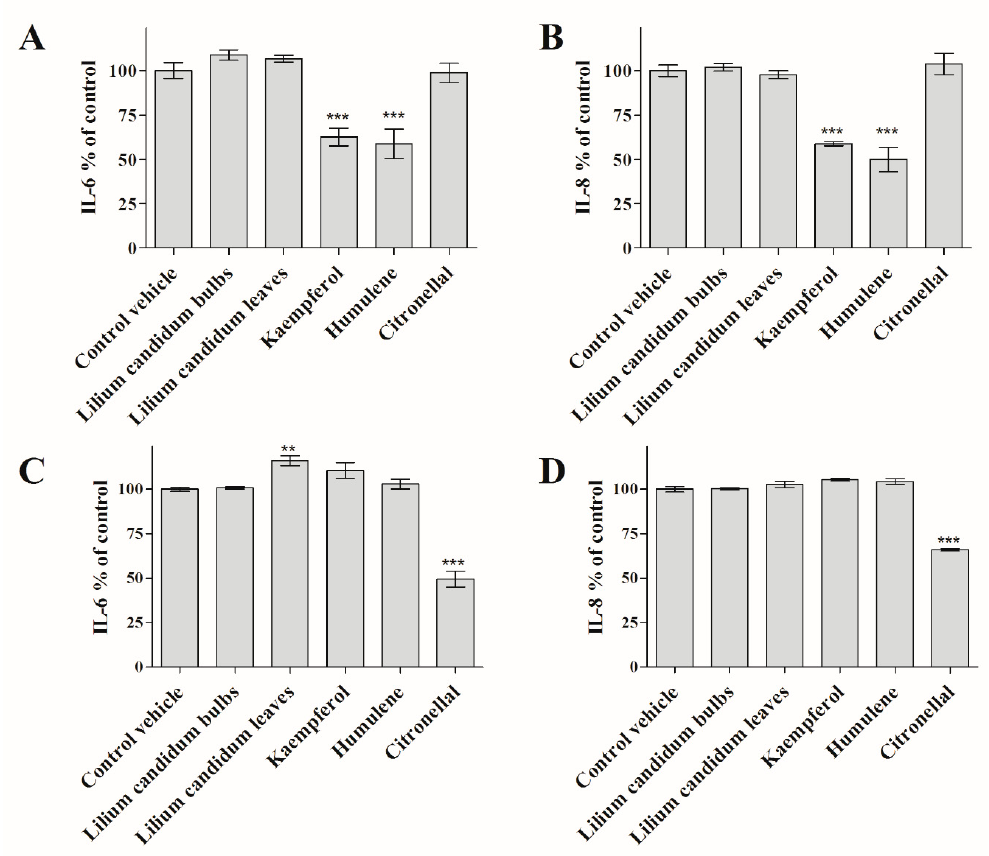
Figure 4. Effect of L. candidum ethanolic extracts and compounds on the release of pro-inflammatory cytokines interleukin 6 (IL-6) ( A , C ) and interleukin 8 (IL-8) ( B , D ) from human pulmonary fibroblasts (HPFs) ( A , B ) or human dermal fibroblasts (HDFs) ( C , D ). The ethanolic extracts were diluted in medium to a final ethanol concentration of 0.1%. Cells treated only with 0.1% ethanol (the vehicle) were used as controls to exclude the effect of ethanol on the cells. Data from three independent experiments are shown (mean ± SE). ** p < 0.01, *** p < 0.001.